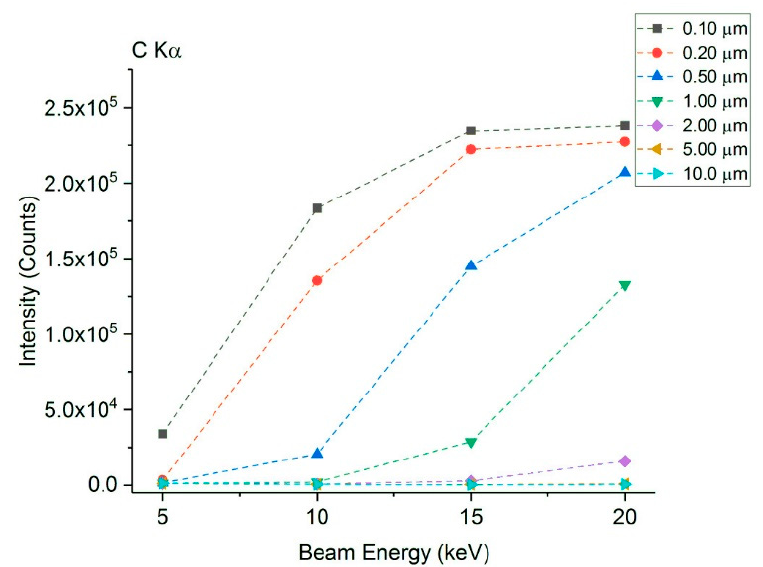
Figure 3. Simulation of the scanning electron microscopy (SEM)-energy-dispersive X-ray spectroscopy (EDS) X-ray intensity of the carbon K α line coming from the substrate, as a function of both the electron beam energy and thickness of the prismatic-shaped Egyptian blue pigment fragment. The statistical variation for each point is about 1%.